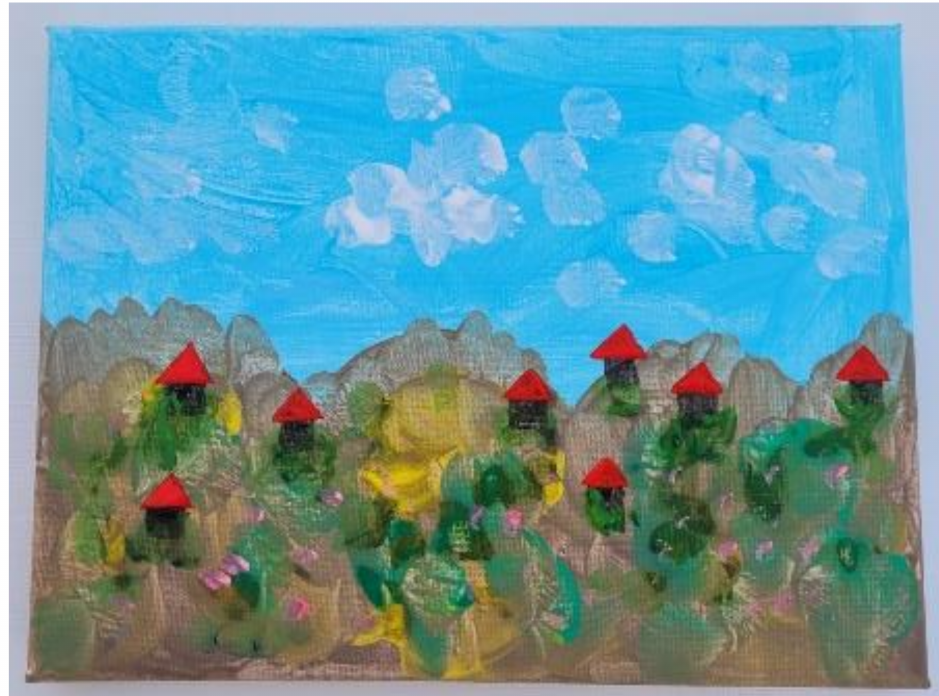
Figure 3. Liora’s painting of houses in the